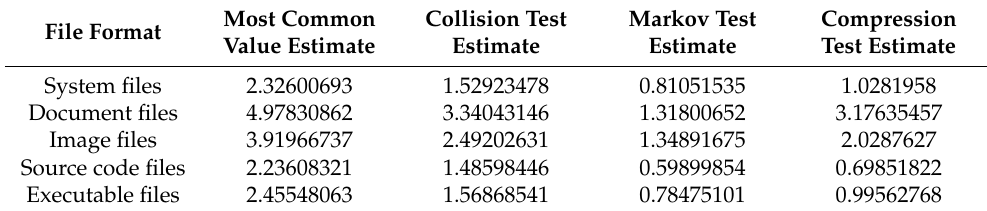
Table 1. Entropy averages for 100 files in each file